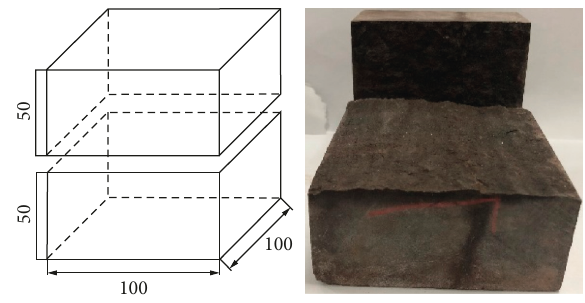
Figure 1: Single-joint specimen.